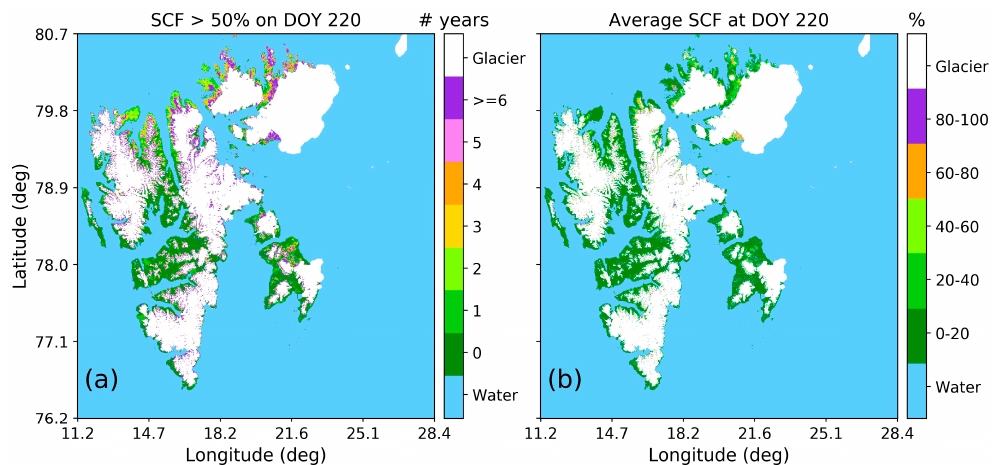
Figure 5. ( a ) Number of years when snow cover fraction (SCF) > 50% on 8 August and ( b ) average snow cover fraction at minimum snow cover 8 August (DOY 220) for 2000–2019.